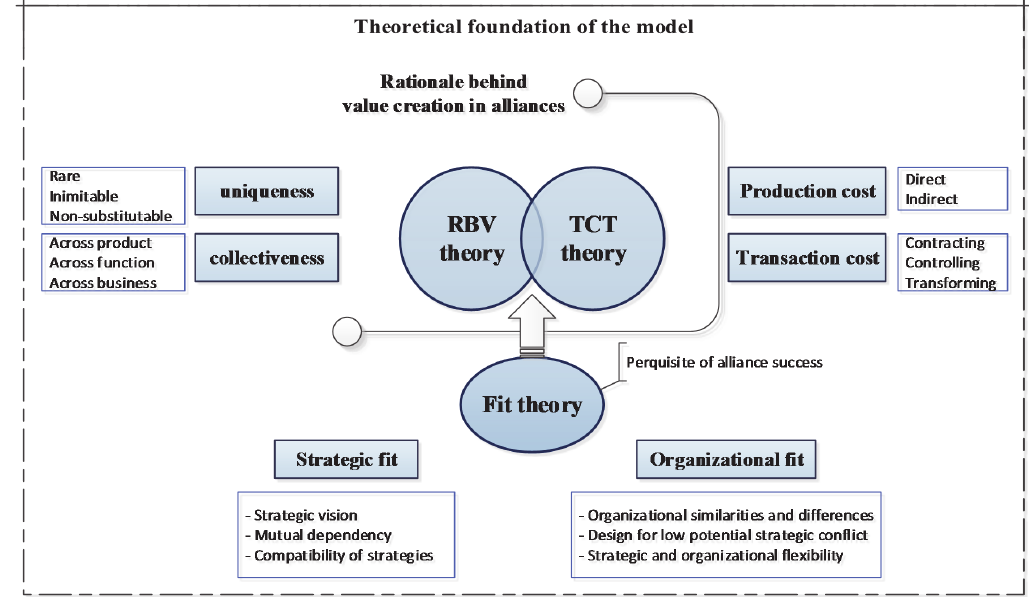
Fig 4. The theories and assessment criteria in the conceptual